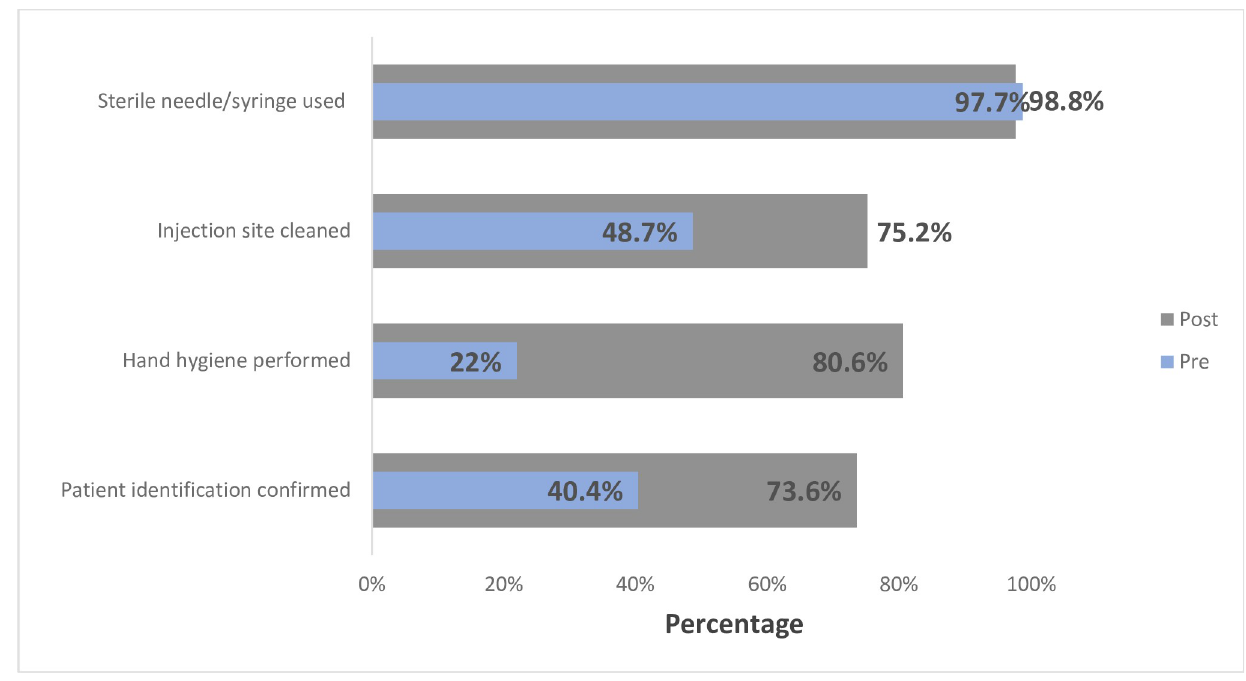
Fig 2. Combined pre- and post-training assessment of safe injection practices affecting patients (Therapeutic observations).